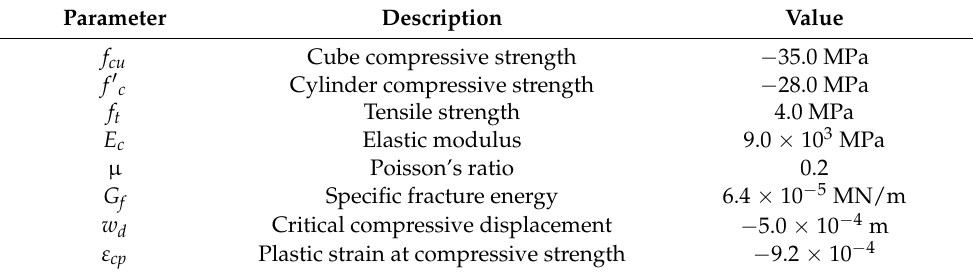
Table 7. Input data for the cementitious matrix used with PBO.